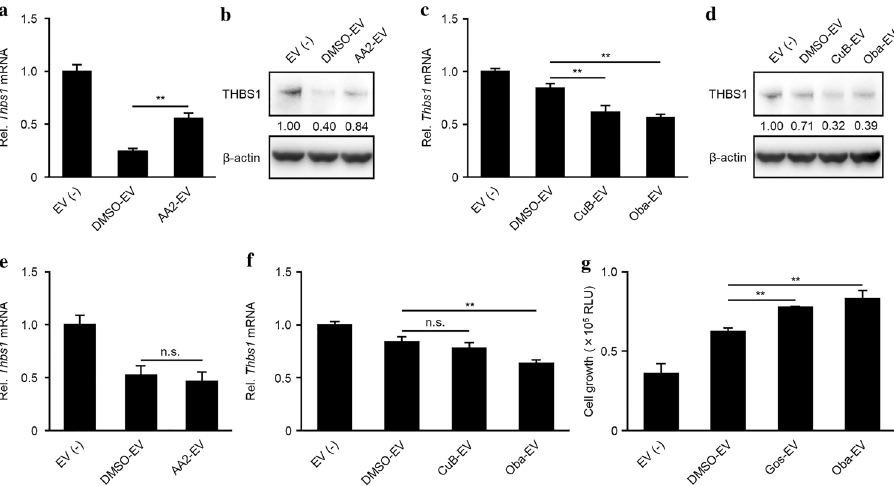
Figure 4. AA2, cucurbitacin B, gossypol, and obatoclax can regulate EV bioactivity in vitro. ( a – f ) DMSO-, AA2-, CuB-, or Oba-EVs were isolated from the cultured supernatant of U87MG cells following treatment for 2 days with DMSO, AA2, cucurbitacin B, or obatoclax. MG6 cells were stimulated with EVs isolated from the same number of U87MG cells ( a , b ; 1 × 10 7 cells, c , d ; 3 × 10 6 cells) or with the same number of EV particles ( e ; 1 × 10 10 particles, f ; 3 × 10 9 particles) for 12 h. Total RNAs or cellular proteins were extracted from MG6 and